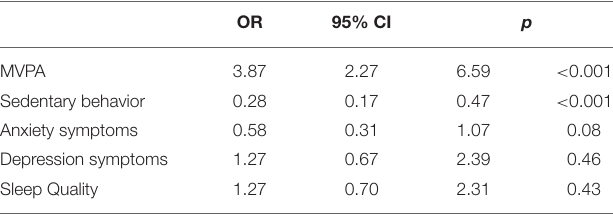
TABLE 4 | Regression logistic association of course (MED or PE) and meet MVPA recommendation, accumulated < 8h of SB, Anxiety symptoms ( < 12 points), Depression symptoms ( < 10 points), and Poor Sleep Quality ( ≥ 6